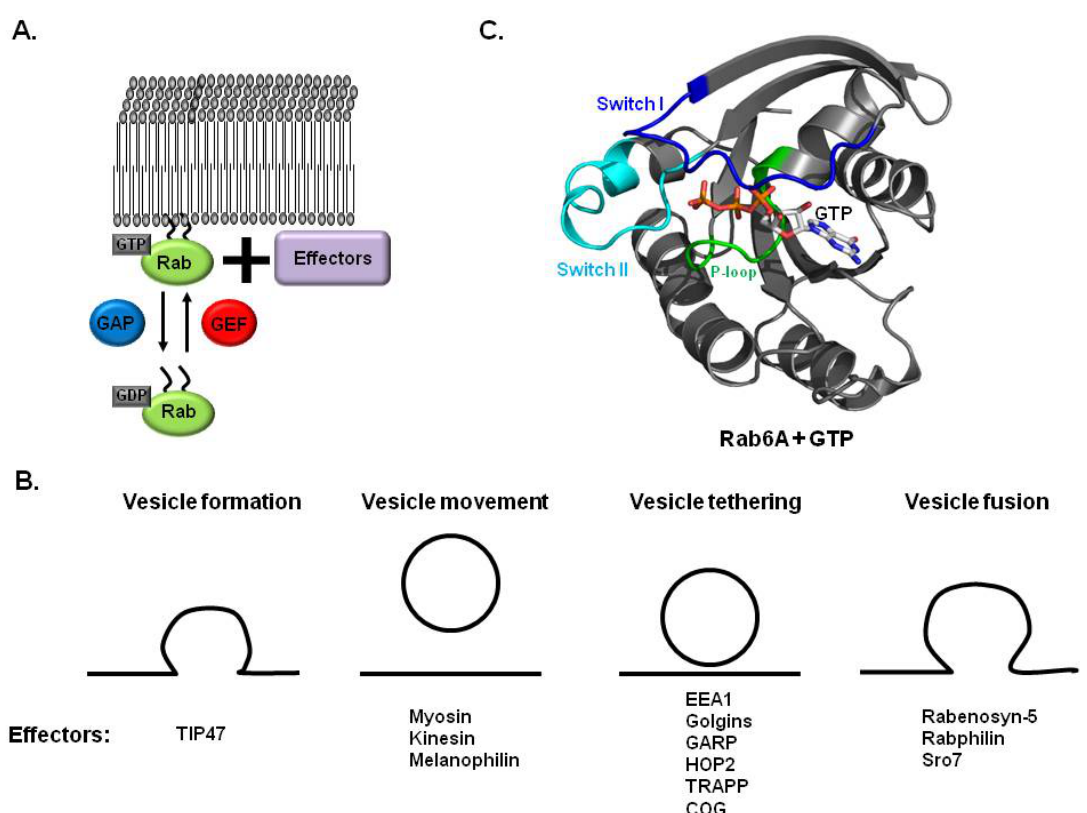
Figure 1. ( A ) Schematic model of the nucleotide and membrane recruitment cycles of Rab GTPases; ( B ) Involvement of Rab effectors during different stages of membrane trafficking. Rabs can properly execute their various functions by recruiting specific effectors during membrane trafficking; ( C ) Crystal structure of the Rab6A/GTP complex (PDB ID: 2GIL). GTP is shown as a stick model with colors. P-loop: phosphate binding loop formed by GXXXXGKS(T); Switch I: corresponding amino acid 38–49; Switch II: corresponding amino acid 69–81). Switch I and switch II are importance for GDP-GTP exchanged mediated activity